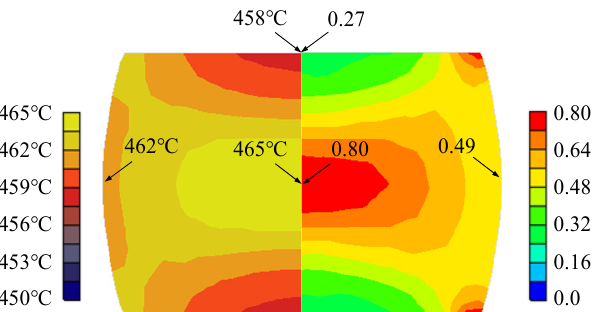
Figure 8. Predicted temperature ( left ) and effective strain ( right ) at the final stroke of cylinder compression test at the 450 °C temperature and 10 s − 1 strain rate.